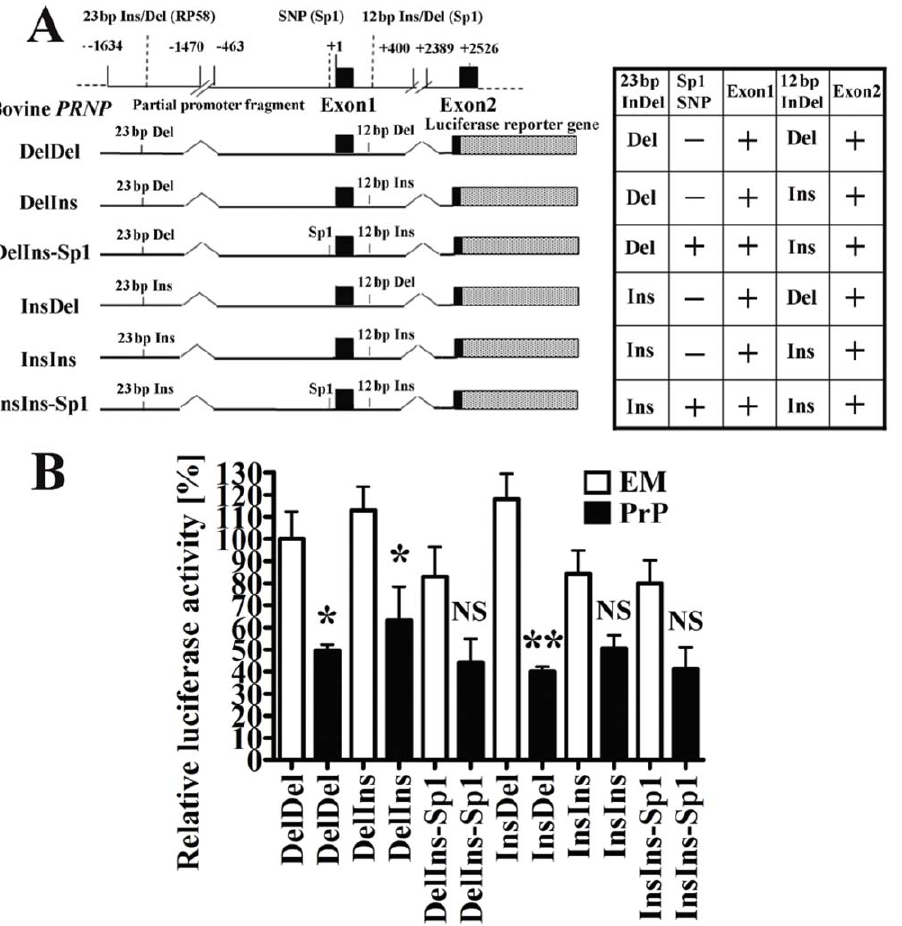
Figure 2. SNP constructs show that the 23-bp deletion in the upstream region of PRNP and/or a 12-bp deletion in intron1, coupled with the absence of the Sp1 SNP and the presence of exon1, are required for the negative feedback response to PrP overexpression. (A) Map of the portion of bovine PRNP containing the 5 9 -flanking region and exons 1 and 2 is shown on the top line. Dotted box=Luciferase gene; black boxes=exon 1 and exon 2, which include numbers denoting the position of the reported transcription start site ( + 1) of the PRNP promoter region. The 23-bp indel, 12-bp indel, and SNP regions are also indicated above the reporter gene constructs. The absence ( 2 ) and presence ( + ) of each region in the reporter gene constructs are shown in the Table on the right. (B) Graph representing the relative luciferase activities obtained with the above reporter plasmids in the presence of either an empty vector, pEF-BOS (EM, open bars), or pEF-boPrP (PrP, solid bars). The pGL3-Control vector (with the standard SV40 promoter) was used for normalization between different experiments (relative light units ( RLU )=(firefly luciferase construct / total protein construct )/(firefly luciferase control / total protein control )). Relative luciferase activities (Mean 6 S.D.) for 3 replicate experiments were compared with that of the pGL3-control plasmid (1%). A significant difference of luciferase activity in pEF-boPrP-transfected cells as compared with corresponding empty vector-transfected cells is shown by one asterisk (*, , 0.05) or two asterisks (**, , 0.01). NS indicates no significant